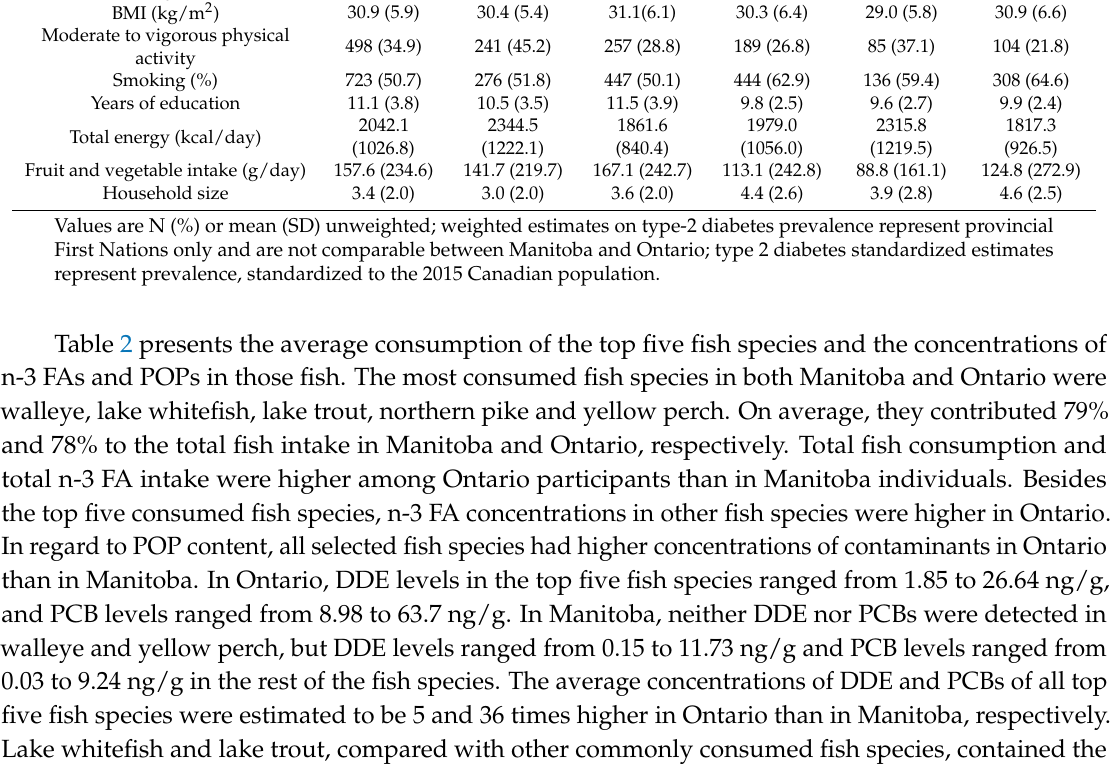
Table 1. Descriptive characteristics of Ontario and Manitoba First Nations (FNs) participants. Ontario Manitoba Variables Total Male Female Total Sample size 1426